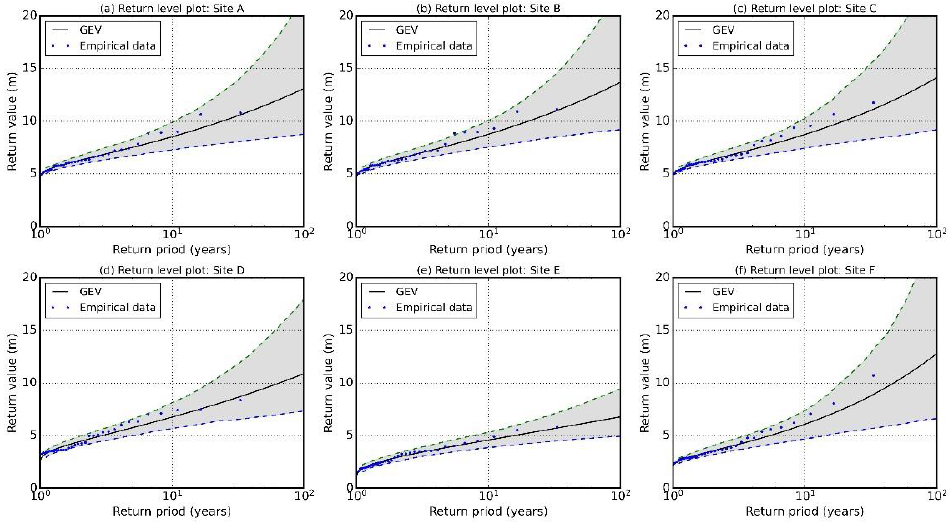
Figure 25. Regression curve of Hs at sites using the AM-GEV method.